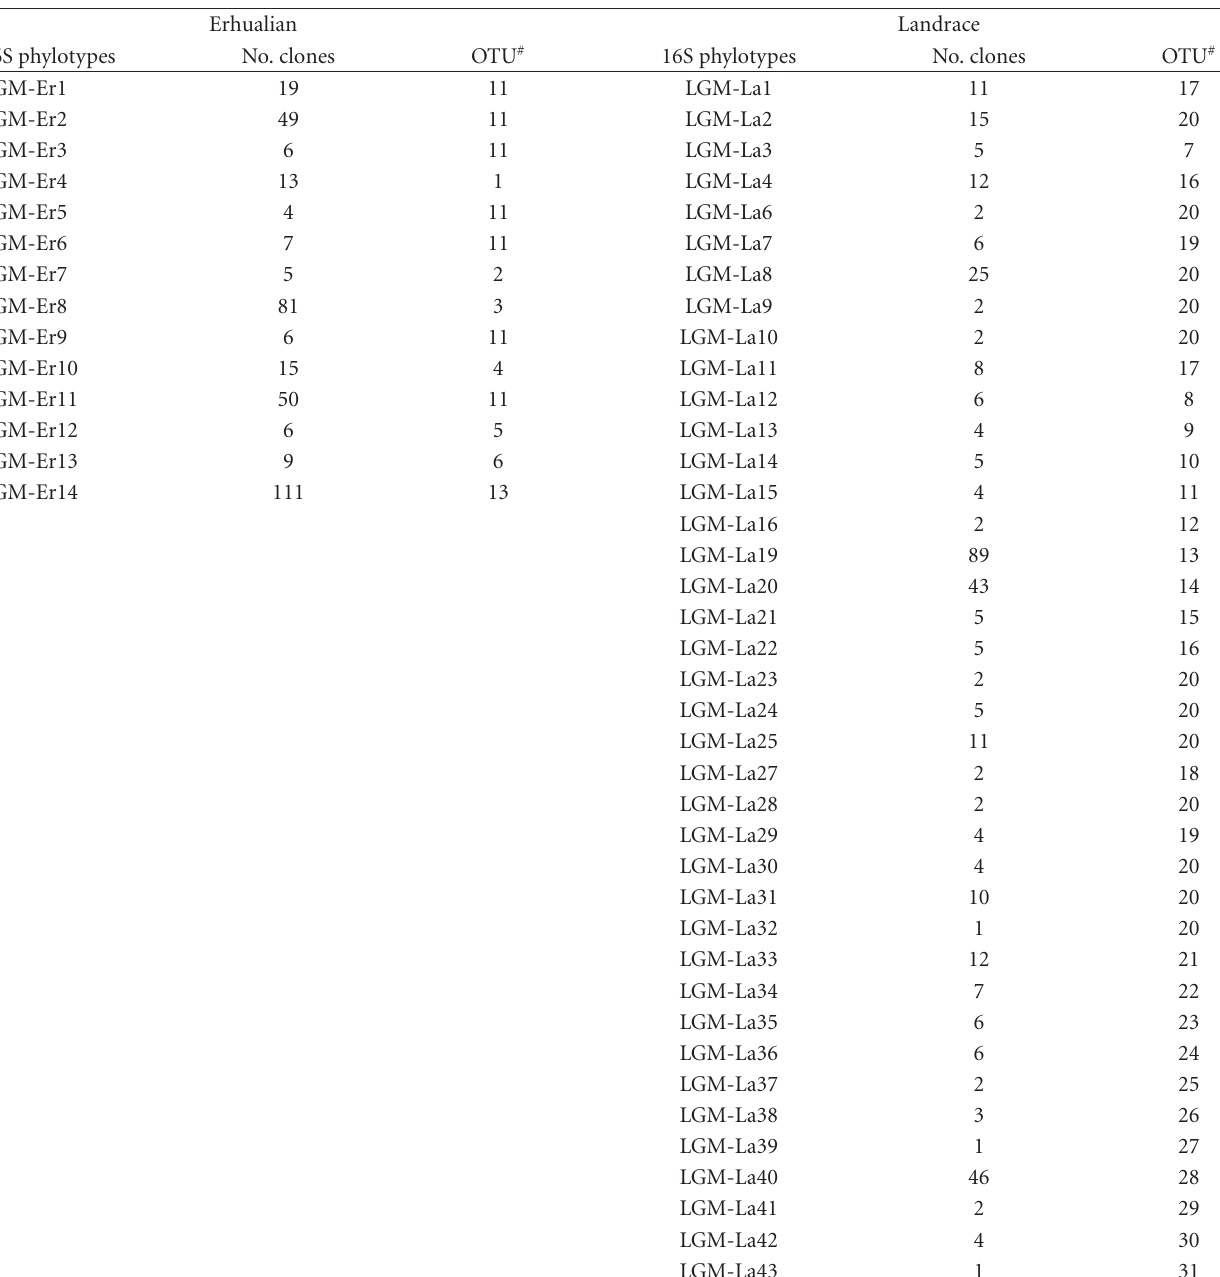
Table 1: 16S rRNA sequences from feces of Erhualian and Landrace